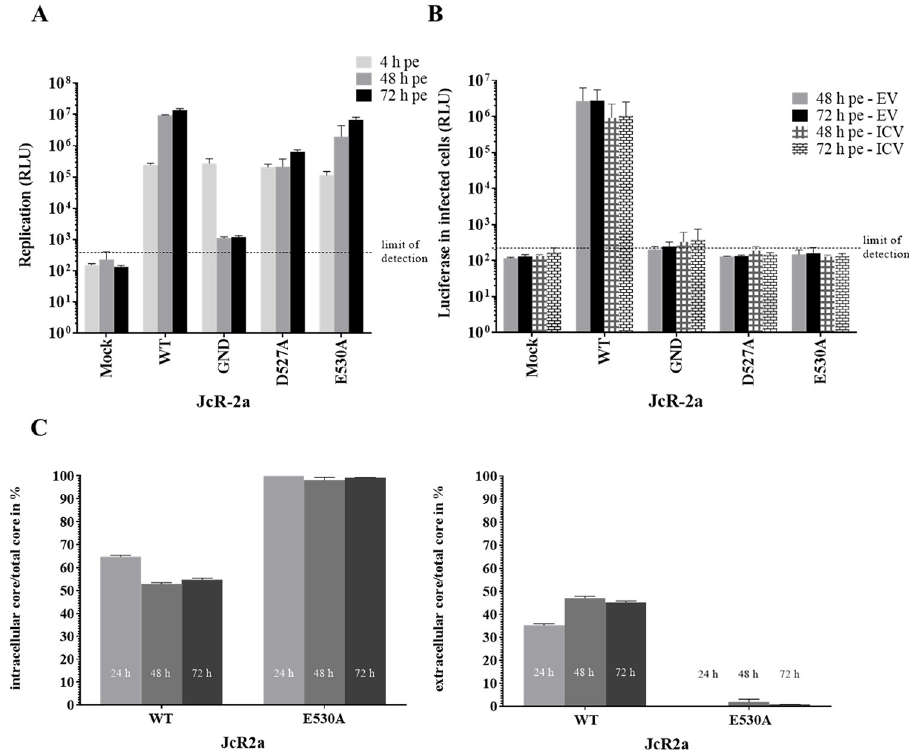
Fig 6. NS3 mutations D527A and E530A inhibit viral particle production prior to virion release and before the formation of infectious intracellular virions. (A, B) The NS3 surface mutations D527A and E530A inhibit the formation of infectious intra- and extracellular virus particles. (A) Huh7.5 cells were electroporated with HCV JcR2a RNA genomes specified at the bottom of the graph and 4, 48 and 72 h later, their replication capacities were determined by Renilla luciferase assay using cell lysates. (B) The cell-associated (ICV) and extracellular (EV) infectivity was determined by inoculating na ï ve Huh7.5 cells with cell lysates or culture supernatants of transfected cells and measuring Renilla luciferase activity 72 h pi. For each time point the amounts of ICV and EV infectivity are given. Mean and SEM of three independent experiments are shown. (A, B) The background of the assay is indicated by the horizontal dashed line. (C) The E530A mutation causes a massive block in core protein release. To determine amounts of intra- (left panel) and extracellular (right panel) core protein, cell lysates and cell culture supernatant from Huh7.5 cells electroporated with WT or E530A HCV JcR2a RNA genomes were subjected chemiluminescent microparticle immunoassay (CMIA), respectively. The intracellular (left panel) and the released (extracellular, right panel) core protein amount was normalized to total core protein amount (intra- and